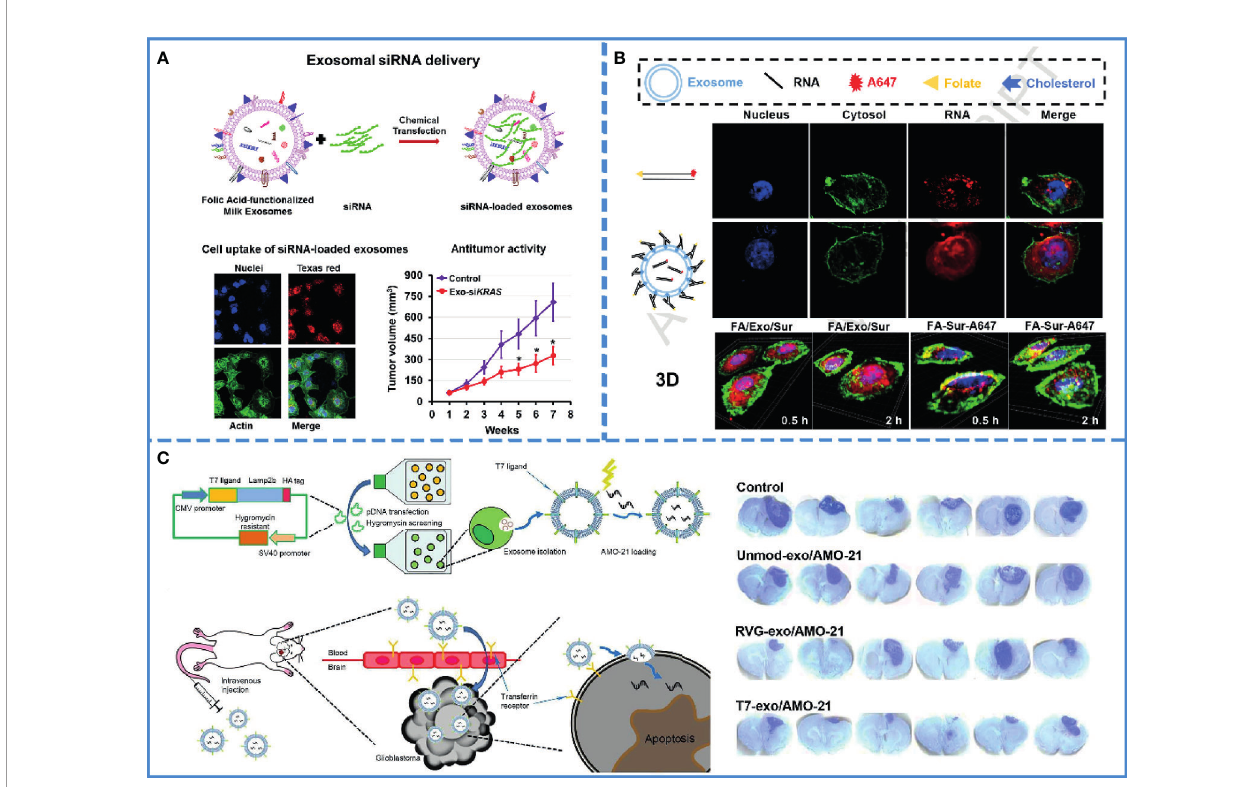
FIGURE 3 | RNAi-based cancer therapy. (A) Schematic illustration of folic acid-functionalized milk exosomes loaded with siRNA via chemical transfection. Reproduced with permission from ref (69). Copyright 2019 Elsevier. (B) FA-decorated exosomes loaded with siRNA were uniformly distributed in the cytoplasm, and there was little overlap with the endosomes/lysosomes in the cells, indicating that exosomes with folate targeting had effective cytosol delivery property. Reproduced with permission from ref (100). Copyright 2019 Elsevier. (C) Schematic illustration of the synthesis of a T7 peptide-decorated exosome (T7-exo). After systemic administration, the T7-exo could cross the BBB, bind to glioblastoma, and enhance the ef fi ciency of AMO delivery. Reproduced with permission from ref (79). Copyright 2019